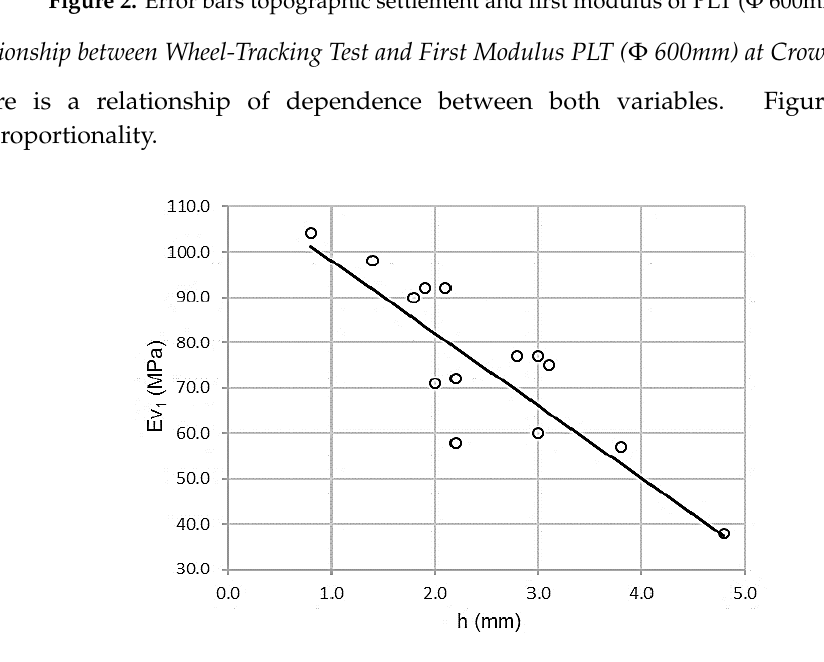
Figure 3. Scatterplot for wheel-track test and first modulus of PLT ( Φ 600mm).